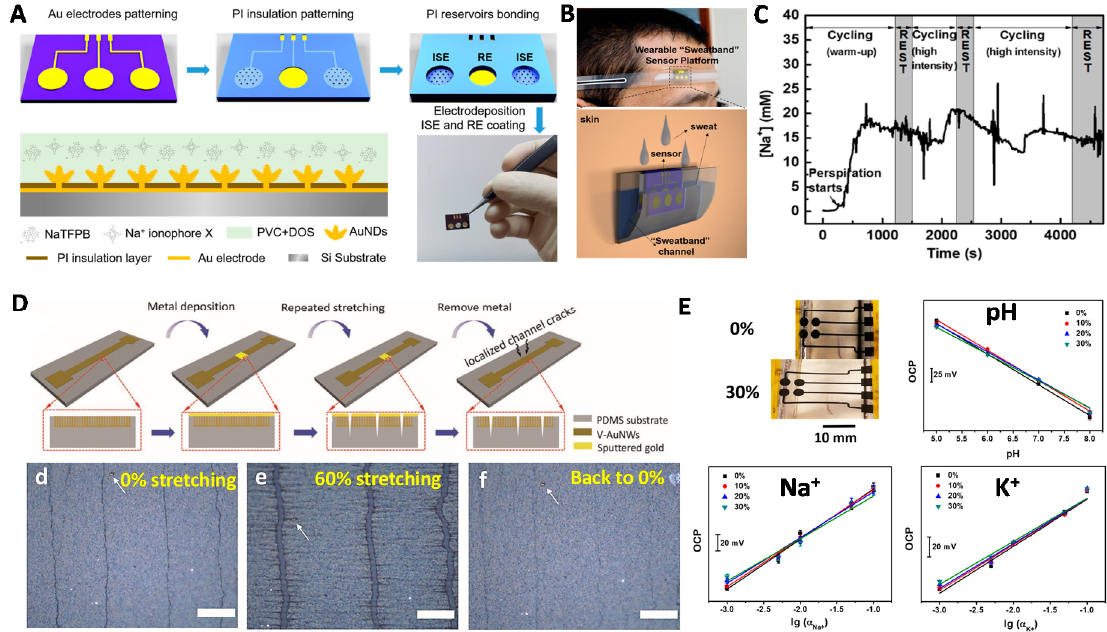
Figure 10. Au nanomaterials-based wearable SC-ISEs for skin sweat ion sensing. ( A – C ) AuND array-based SC-ISEs for sweat Na + sensing. ( A ) The preparation procedure for AuND-based SC-ISEs by photolithography technique. ( B ) A schematic for the SC-ISEs on-body measurement. ( C ) Real-time analysis of sweat Na + during cycling and rest states. Reprinted with permission from [84], Copyright (2017) American Chemical Society. ( D , E ) Gold-based vertically aligned nanowires (V-AuNWs)-based stretchable SC-ISEs for Na + , K + and pH sensing. ( D ) The preparation of V-AuNWs on PDMS film and corresponding optical images for observing the stretching. Scale bar: 200 μm. Reprinted with permission from [85], Copyright (2019) John Wiley and Sons publications. ( E ) The Na + , K + and pH sensing from 0% to 30% stretching. Reprinted with permission from [86], Copyright (2020) American Chemical Society.